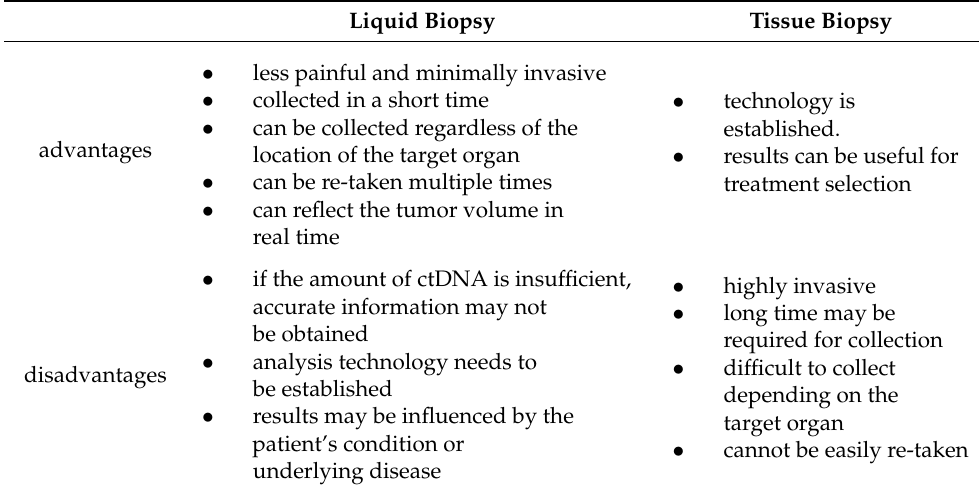
Table 2. Advantages and disadvantages of liquid biopsy and tissue